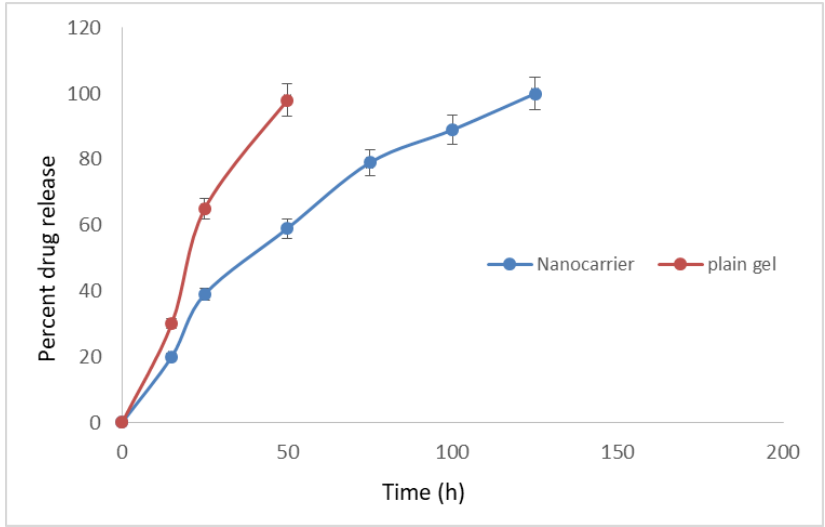
Figure 2. In vitro drug-release profile of the nanocarrier formulation (F1) and the plain gel loaded with ciprofloxacin hydrochloride (bars represent mean ± SD; n =